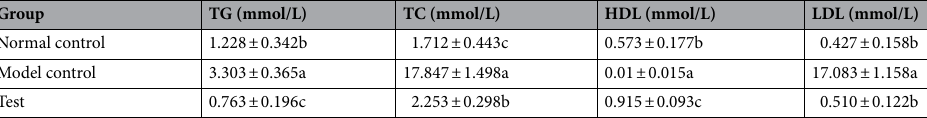
Table 3. Serum lipid level of rat fed with LWIF and control diet. Data are mean values ± standard errors of three replicates. Mean values followed by the different letter in the same row are significantly difference ( P < 0.05).